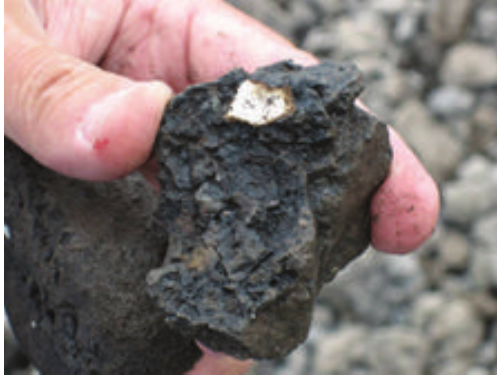
Figure 4: Gravel-size steel slag particle with a lime pocket (photograph taken at Mittal Steel, Indiana Harbor West